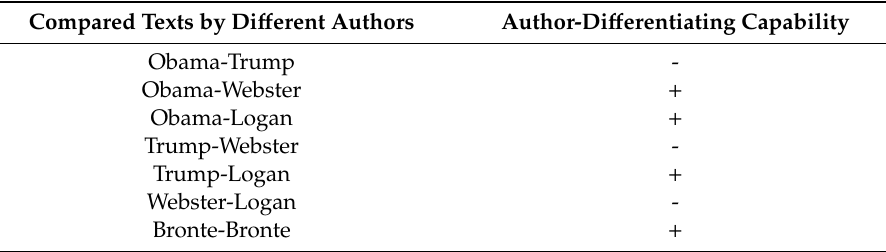
Table 4. The author-di ff erentiating capability of the coronal phoneme group.